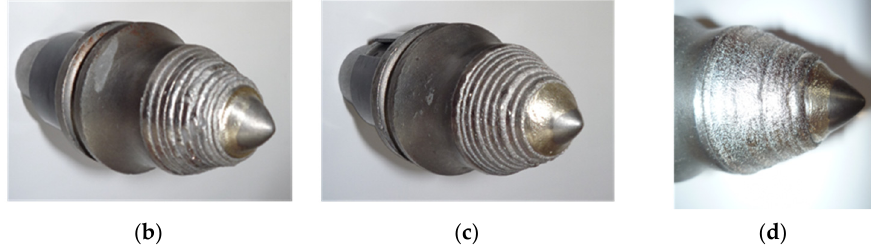
Figure 5. Variants of alloyed powder and laser metal deposition on the frustoconical section of the tooth; ( a ) two cord metal deposition; ( b ) metal deposition with a one-third overlap; ( c ) metal deposition with a two-third overlap; ( d ) optimized metal deposition.